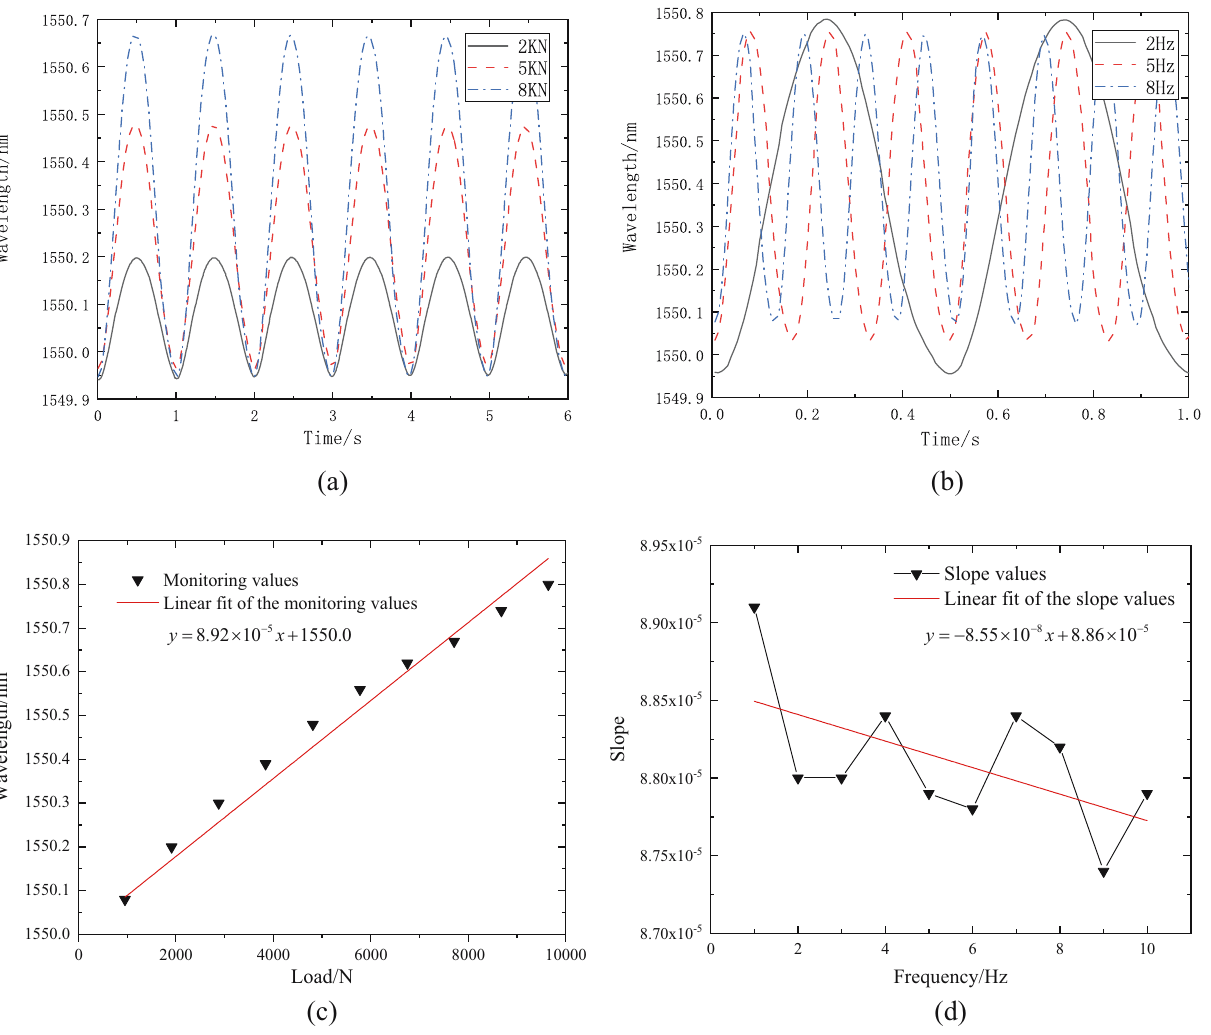
Figure 13: Dynamic load monitoring test results: ( a ) various 1 Hz sinusoidal fl uctuating load measurements, ( b ) various peaks for 10,000 N sinusoidal fl uctuating load measurements, ( c ) linear fi tting of the measured load peak data for 1 Hz sinusoidal fl uctuations, and ( d ) the slope distribution resulting from linearly fi tting various sinusoidal fl uctuation load peak measurement